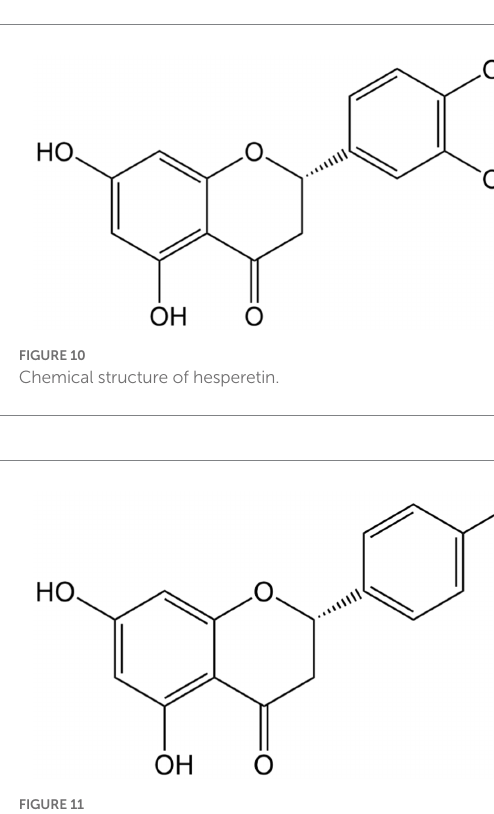
FIGURE 11 Chemical structure of naringenin.